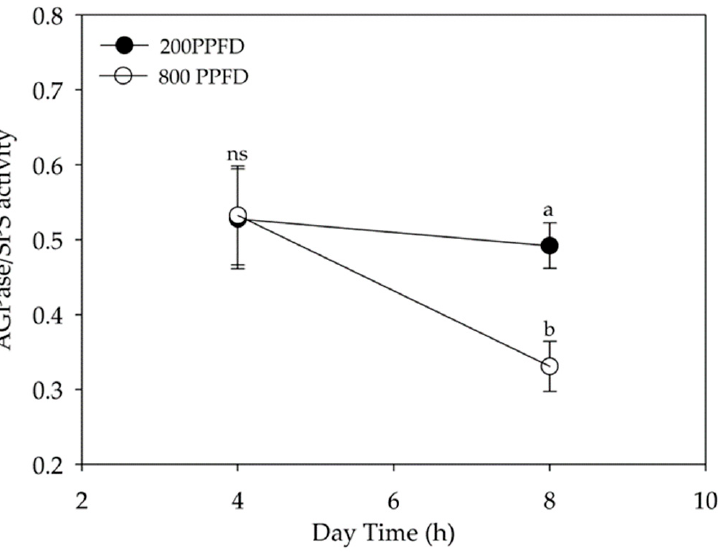
Figure 5. AGP/SPS ratio during the light period in spinach leaves grown in a growth chamber under 800 µ mol m − 2 s − 1 (800 PPFD) and 200 µ mol m − 2 s − 1 (200 PPFD) white light intensity. Mean values ± S.E. (n = 12). Different letters indicate significant differences at p = 0.05 (Fisher’s post-hoc test), ns—not significant.